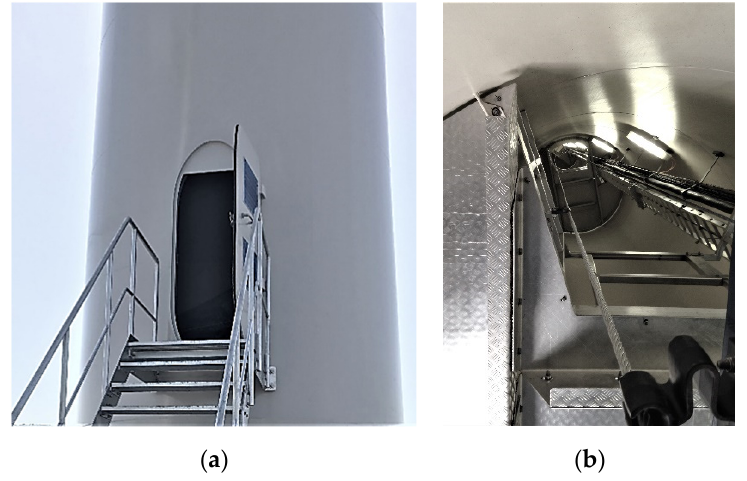
Figure 2. Wind tower segments: ( a ) installed openings; ( b ) the tower interior.